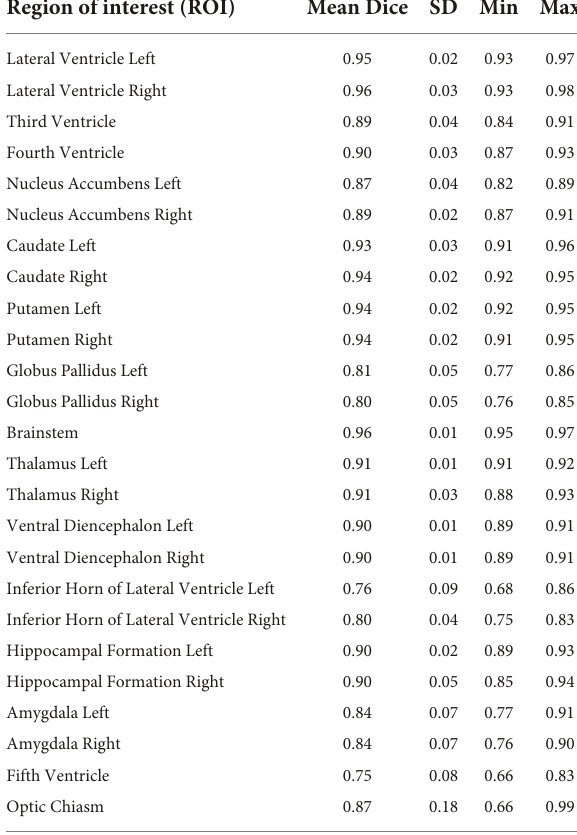
TABLE 2B Intra-rater